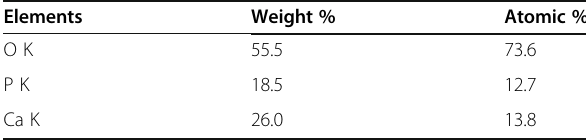
Table 5 EDAX data for undoped CHPD crystal Elements Weight % Atomic